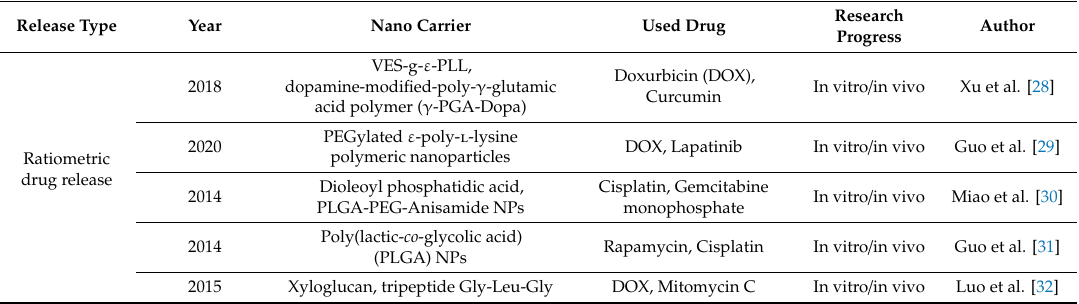
Table 1. Characteristics and research progress classified by the release type of nano-formulated combinatorial drugs